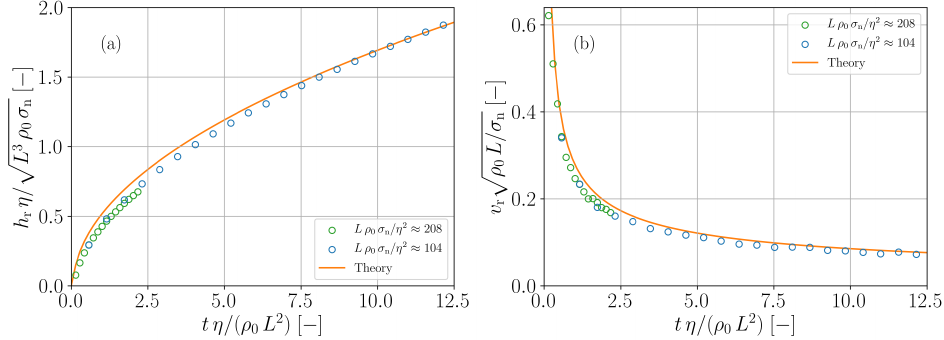
Figure 17. Flow into a nozzle. Normalized rise height ( a ) and normalized rise velocity ( b ) as functions of normalized time in simulations and according to theory (Equations (61) and (62)). Images from the simulation using the spatial resolution L / ∆ x = 100 are displayed in Figure 18. The fluid strongly rises on the left wall due to the Marangoni effect which drives the fluid at the surface from the warm region towards the cold region. The last snapshot shows the steady state where an eddy has formed below the surface.